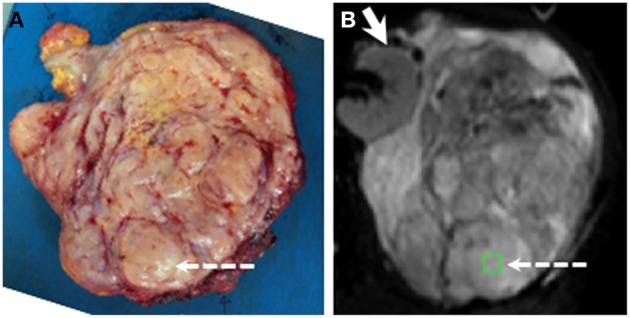
Example showing positioning of ROI for histopathological and radiological analysis. (A) Slice cut by histopathologist. (B) fitted b = 0 s mm−2 image from matching slice in DW-MRI series. ROI shown by green square and dashed arrows. Solid arrow in (B) shows kidney (not removed in surgery). ROIs were chosen jointly by the histopathologist and radiologist using pre-surgical imaging, markers inserted by the surgeon, and anatomical landmarks within tumor. Note ROI lies in a nodule in the posterior part of the tumor.